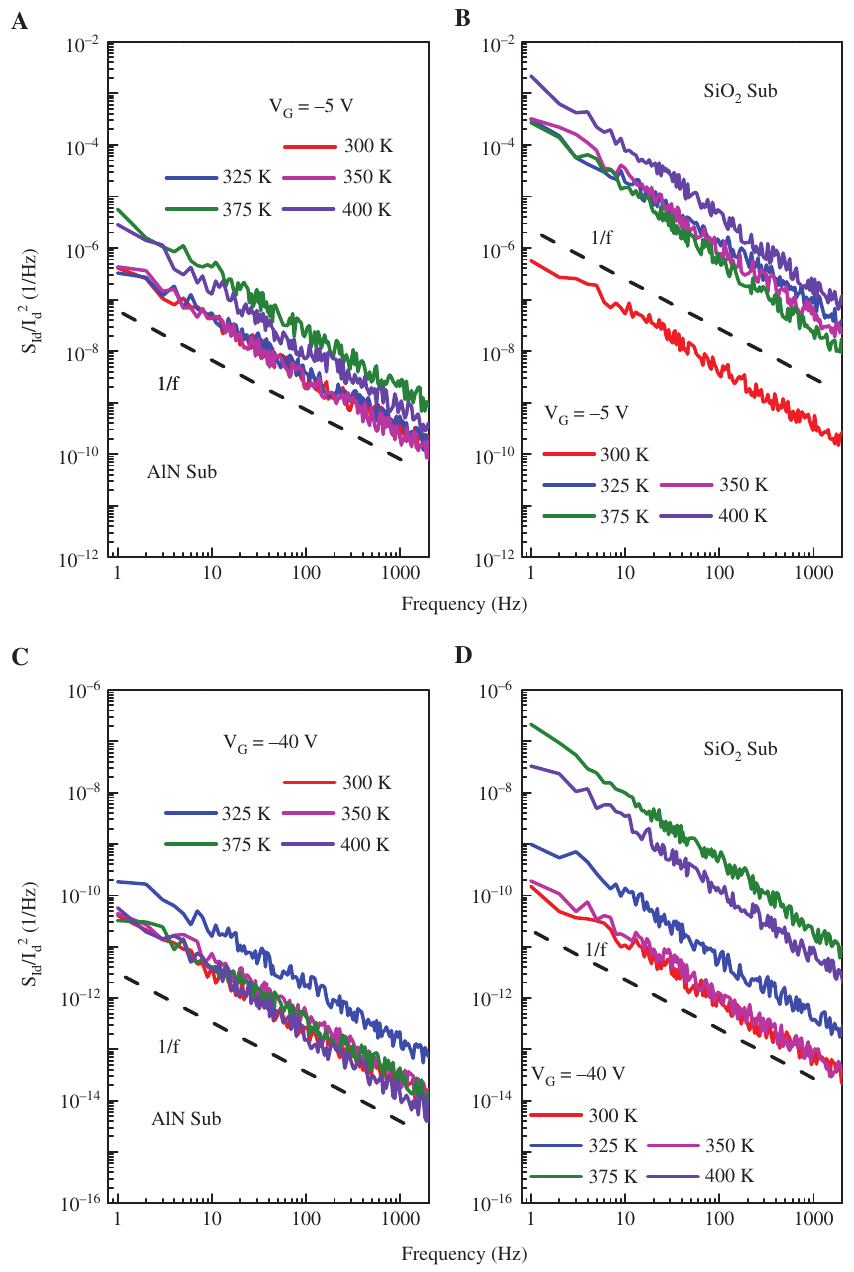
Figure 6: The extracted γ for BP FETs at different temperatures and gate biases. Low-frequency noise (LFN) characteristics of BP FETs as a function of frequency and temperature on substrate of (A) AlN/SiO SiO /Si in the subthreshold region ( V 2